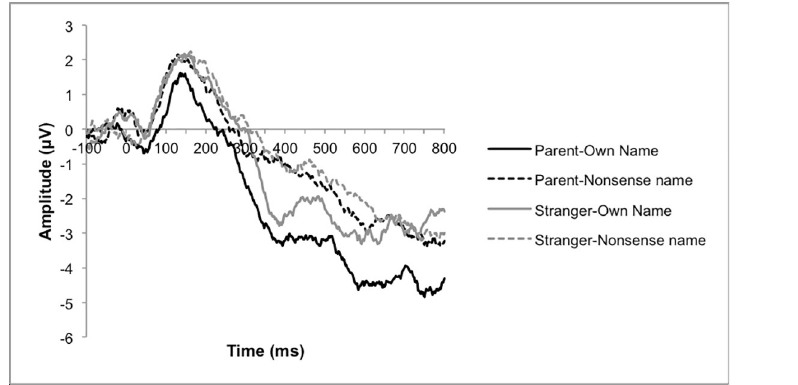
Fig 2. ERP waveforms over frontal regions in the full TD sample in each